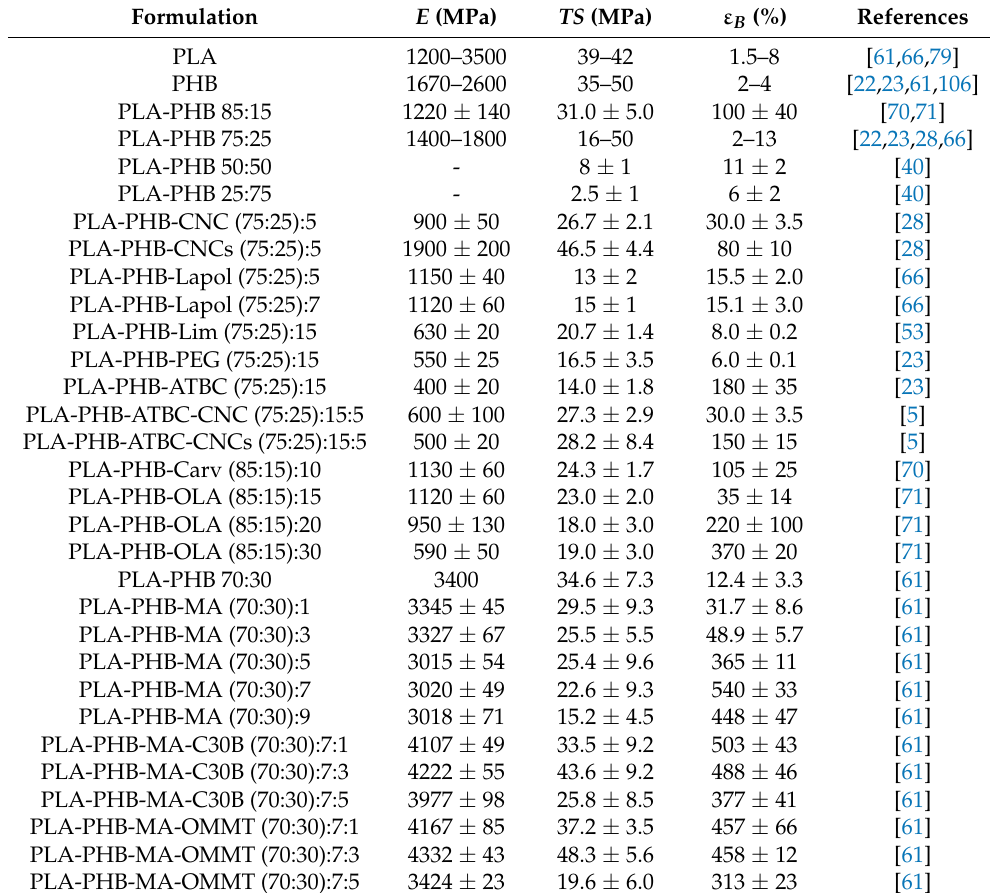
Table 1. Tensile test properties of several PLA-PHB based